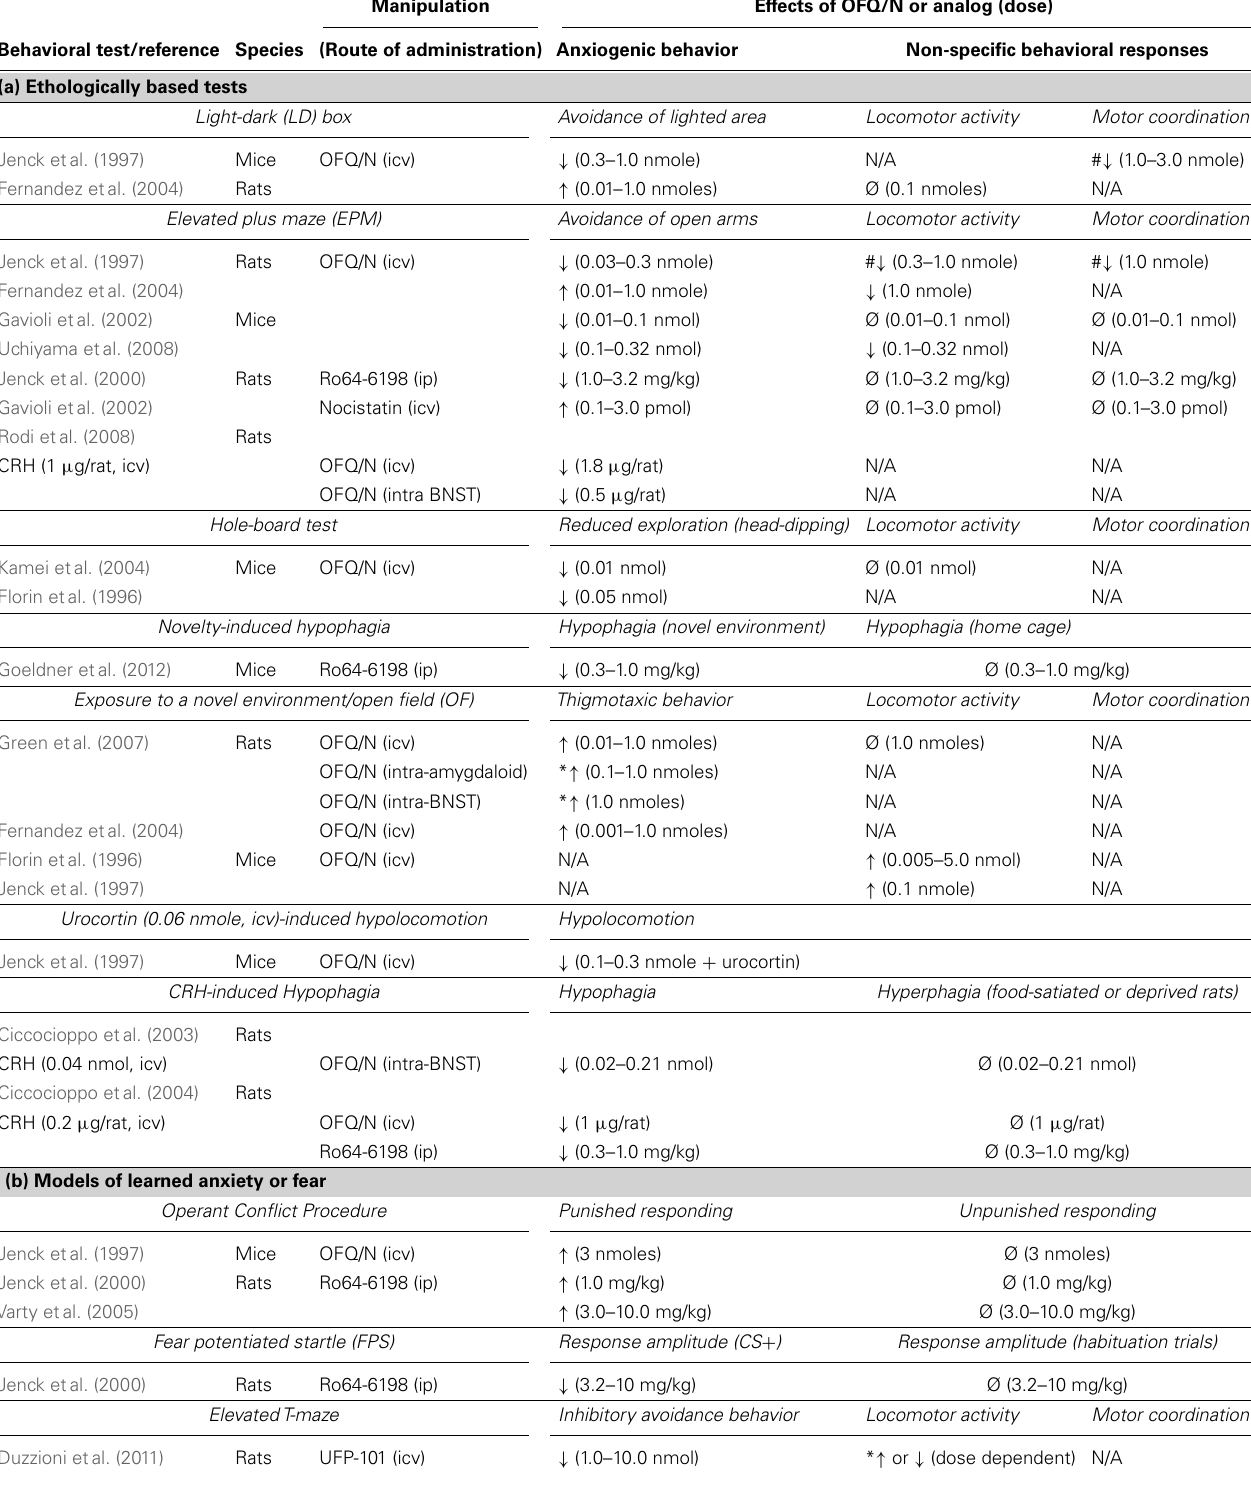
Table 3 | Effects of manipulation of the nociceptin system on the expression of innate (a) and learned (b) anxiety-like behavior in rodents.